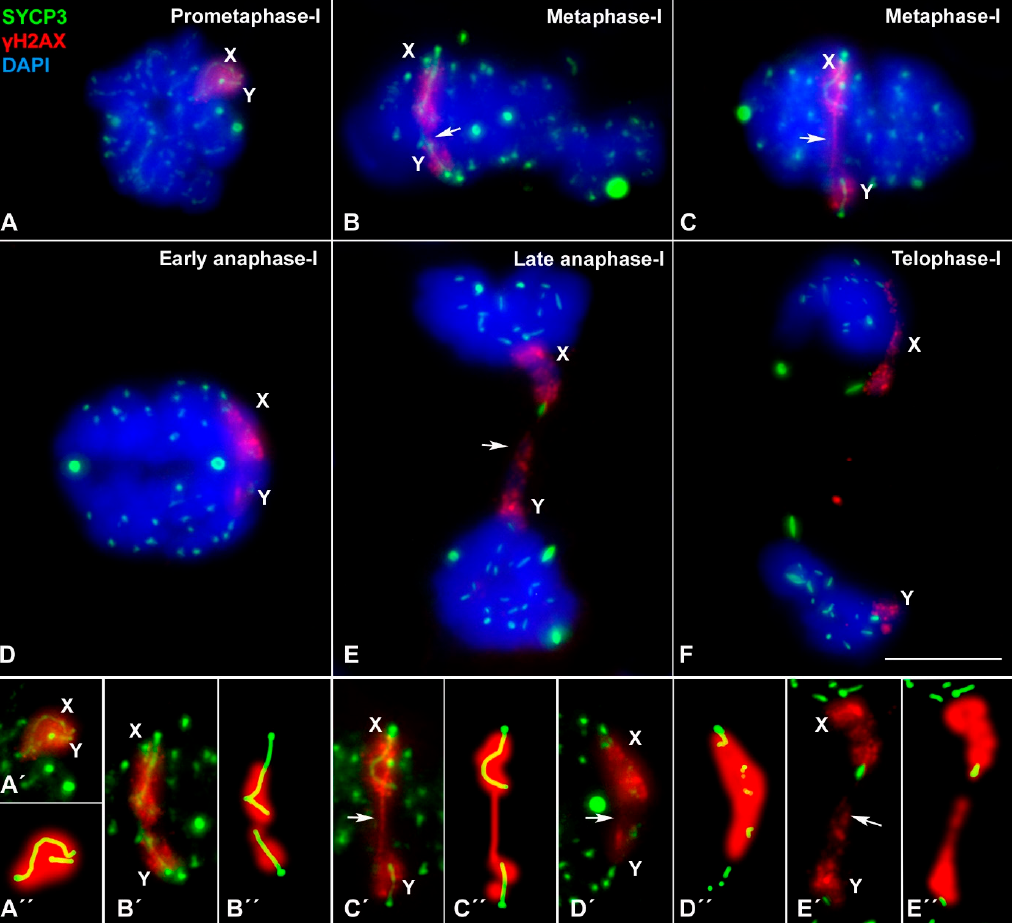
Figure 7. Segregation of sex chromosomes during first meiotic division. Squashed spermatocytes labelled with antibodies against SYCP3 (green) and γ H2AX (red) and counterstained with DAPI (blue). Lower row shows enlarged images of the sex chromosomes presented in ( A – E ). ( A – A ′ ) Prometaphase-I. SYCP3 signal is observed in the autosomes, while γ H2AX marks sex chromosomes, which are tightly associated at the nucleus periphery. ( B – B ′ ) Metaphase-I. Bivalents appear aligned at the metaphase plate. SYCP3 in autosomes accumulates especially in centromeric regions and in some large scattered foci. Sex chromosomes are oriented to opposite poles and appear associated and labelled with γ H2AX, which is continuous between both chromosomes (arrow). The hook-like configuration of the X chromosome is discernible. ( C – C ′ ) Metaphase-I. Autosomal bivalents are aligned at the cell equator, while the sex chromosomes appear further apart. A γ H2AX filament bridges from the X to the Y chromosome (arrow). ( D – D ′ ) Early anaphase-I. Autosomes start migration. SYCP3 is observed as aggregates in the centromeric regions and as large accumulation in the cytoplasm. Sex chromosomes initiate their segregation, but a γ H2AX contact is still observed (arrow). ( E – E ′ ) Late anaphase-I. Two chromatin masses appear clearly separated. A chromatin connection between these two chromosome groups is observed (arrow), most prob- ably representing sex chromosomes. ( F ) Telophase-I. Chromosomes reach the cell poles. A γ H2AX signal is detected in each pole, but without connection between them. ( A ′′ – E ′′ ) shows enlarged images of the sex chromosomes presented in ( A ′ – E ′ ). Scale bar: 10 µm. 4. Discussion The evolution of sex chromosomes is a very active field in evolutionary biology. Se- quencing of these chromosomes has provided a deep understanding of the events in the past that have conditioned their organization and function [66,67]. Although this topic has traditionally been considered from a genetic perspective, recent works have demonstrated